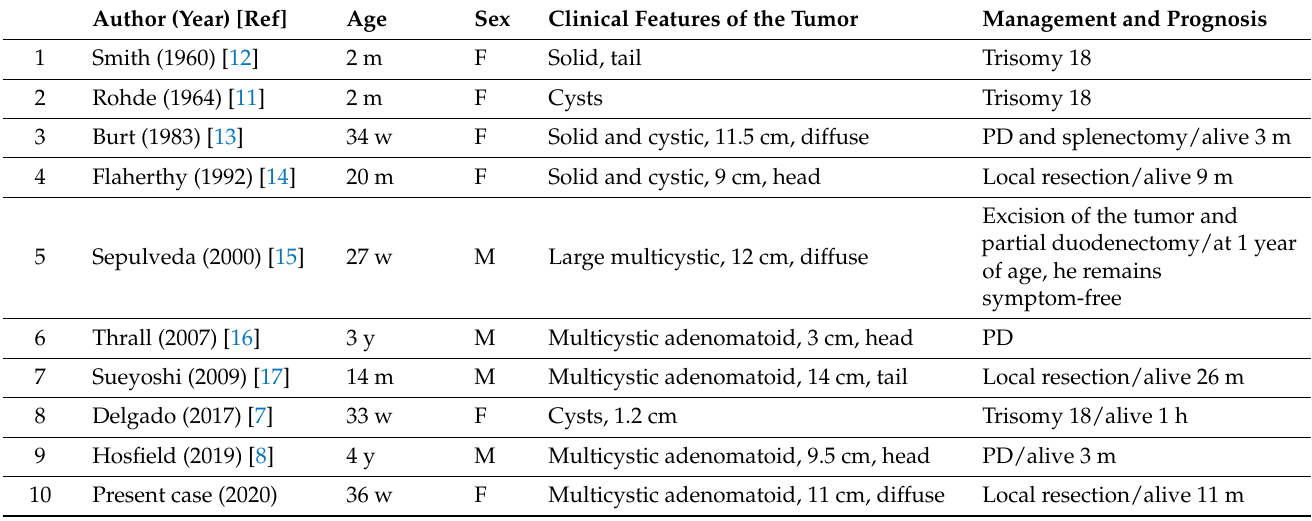
Table 4. Characteristics of pancreatic hamartomas of newborns and children reported in the all-time literature.